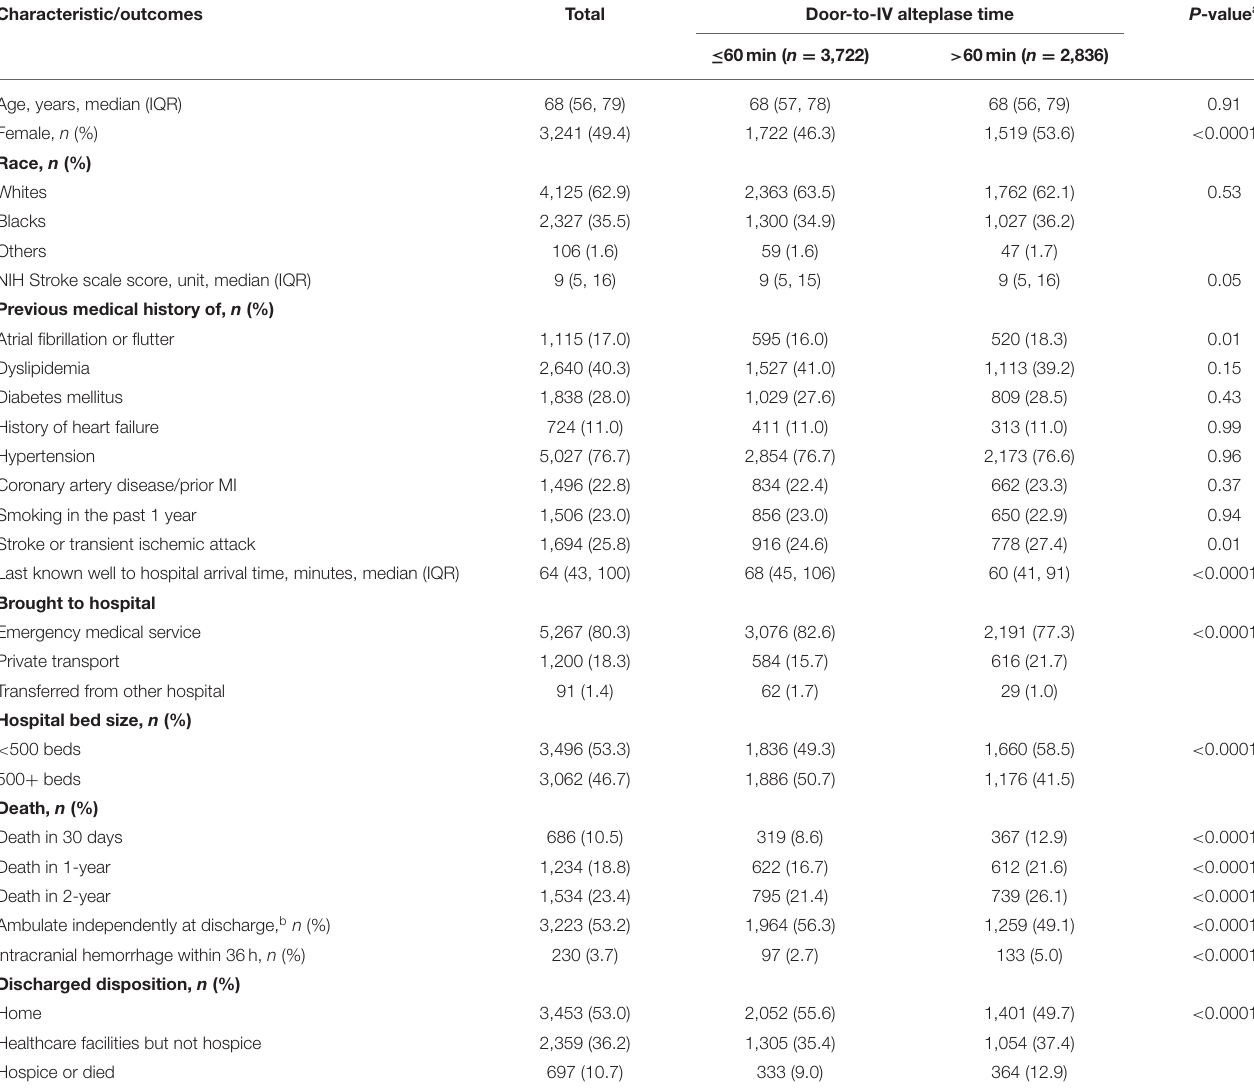
TABLE 1 | Characteristics and outcomes of ischemic stroke patients treated with intravenous alteplase, GCASR, January 2008–June 2018.